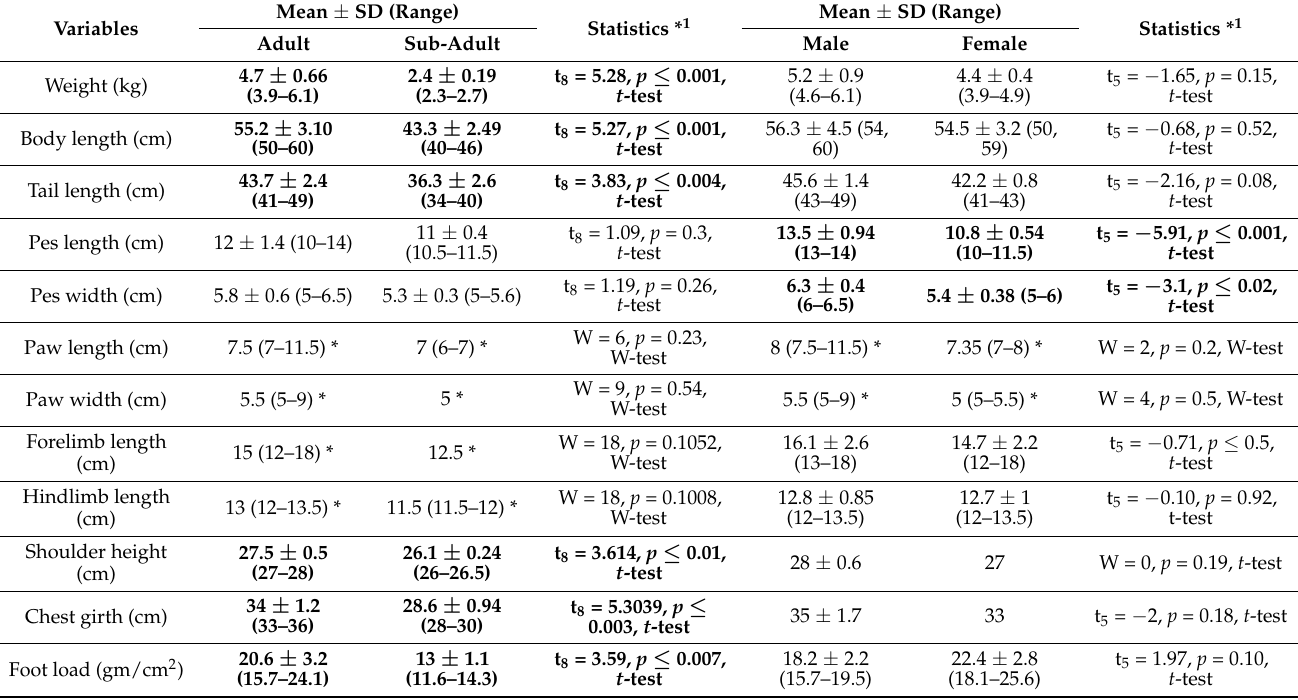
Table 1. Morphometric data of adult males ( n = 3) and females ( n = 4), and adults ( n = 7) and sub-adults ( n = 3). Central tendencies of variables are presented as mean and median for age and sex categories, and range is presented within parentheses as minimum and maximum values. Significant results are shown in